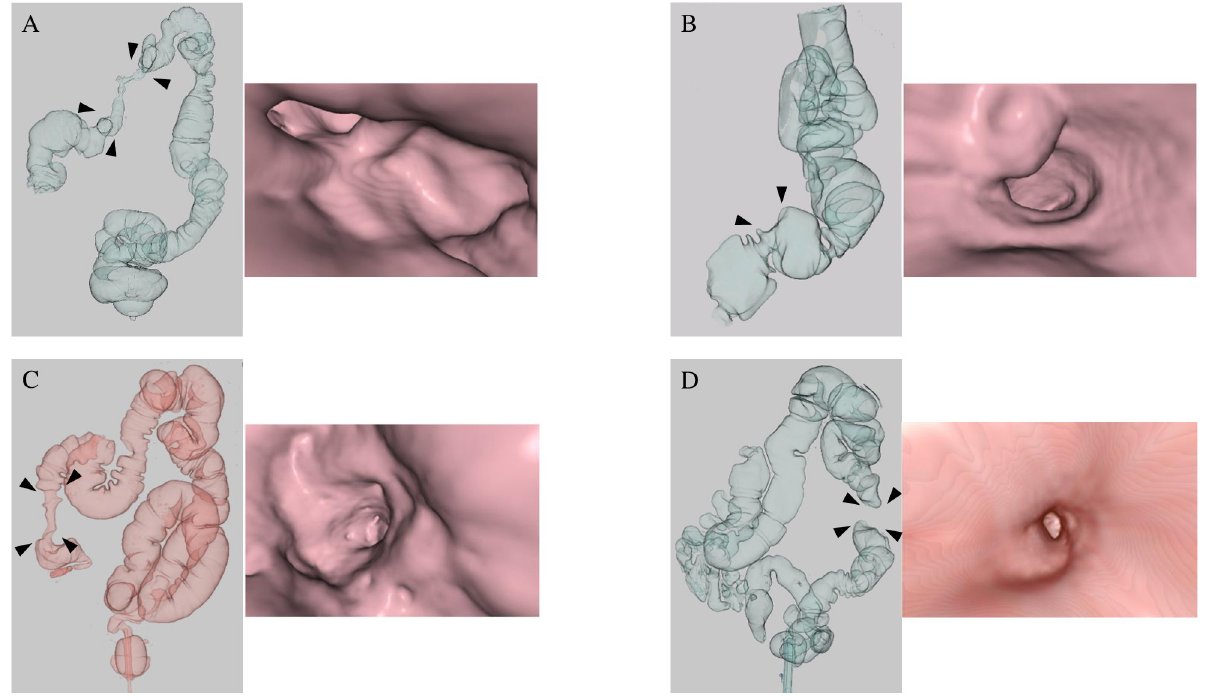
Fig 2. Representative computed tomography colonography (CTC)